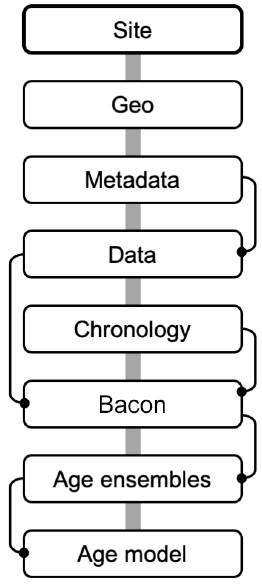
Figure 2. Structure of the PalMod 130k marine palaeoclimate data synthesis. Each file in the database contains information on seven different themes on a single site (sediment core). Links between different themes are